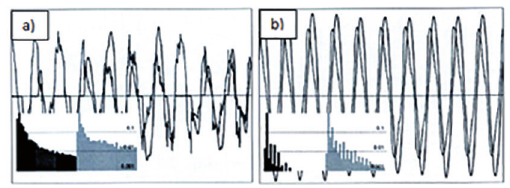
Figure 2: Shapes of sine waves, without foamy slag (a) and with foamy slag (b) 2 .